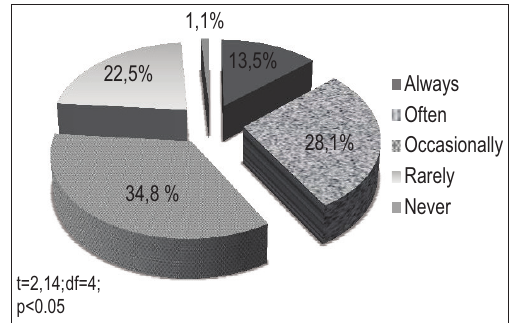
FIGURE 1. Distribution of positive attitude and satisfaction at work in the past 3 months.